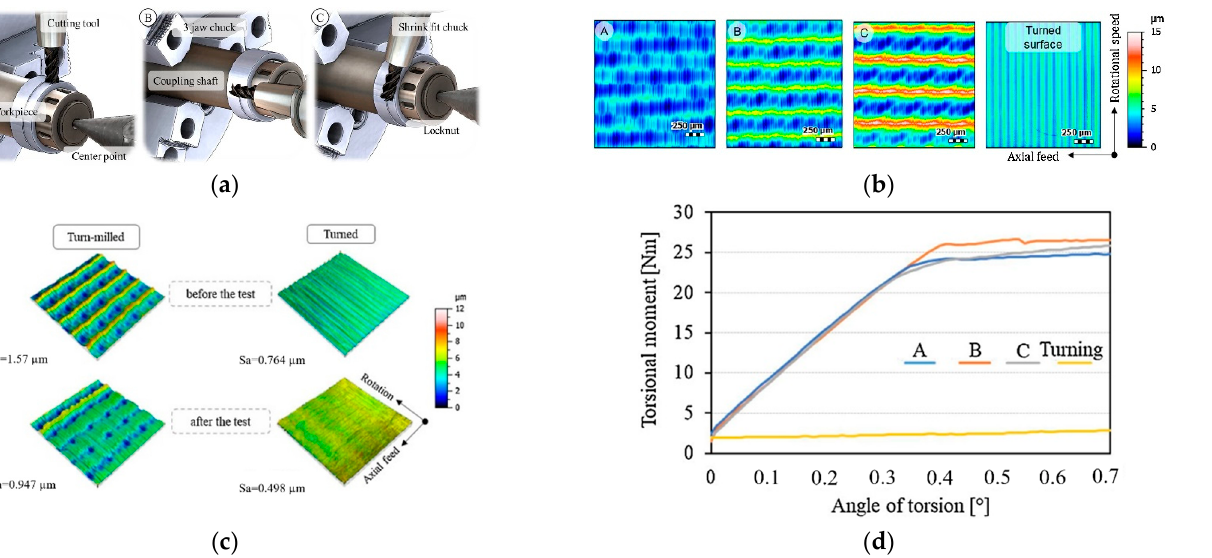
Figure 3. ( a ) Cutting principles for the turned milling process. ( b ) The three surface topographies produced by turned milling process. ( c ) The deformation of surface topographies after the twist-off tests. ( d ) The torque required for dismantling the head–neck junctions [27].